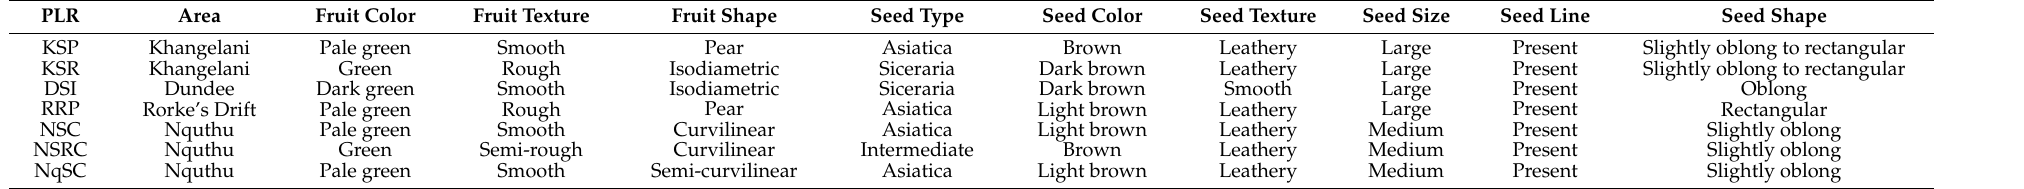
Table 8. Description of parental landraces according to their origin as well as fruit and seed morphology